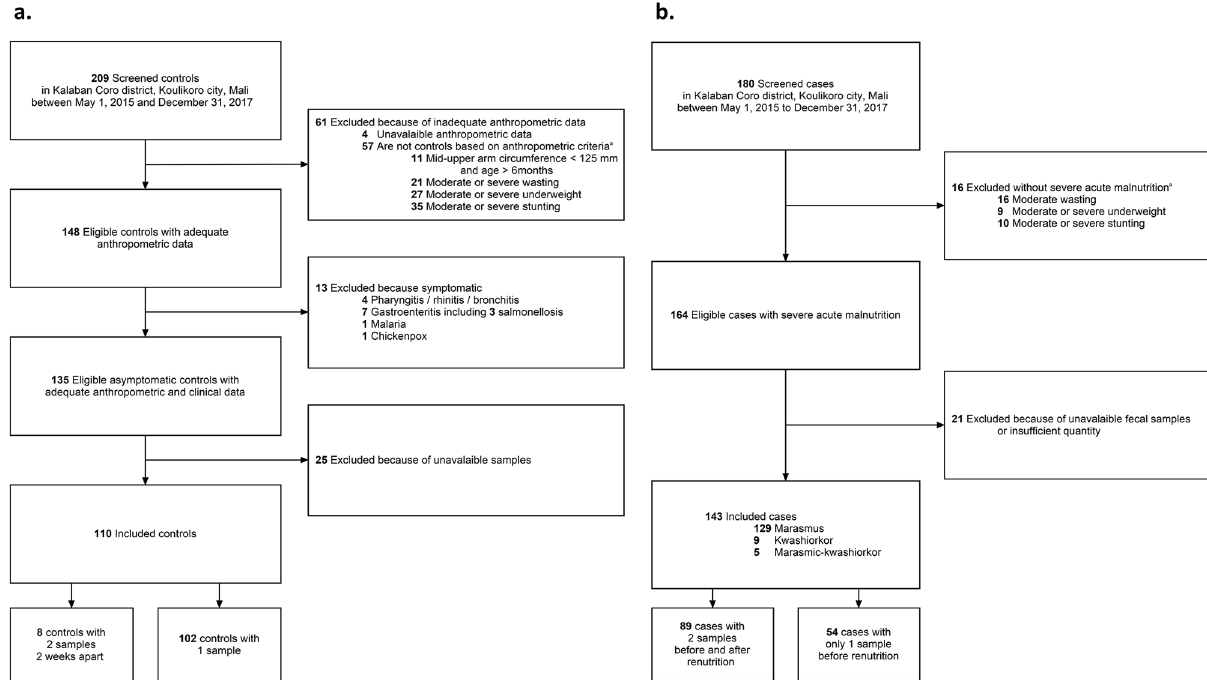
Figure 1. Study flow-chart. ( a ) Case selection, malnourished children are selected based on the WHO severity criterion and before any treatment; the presence of any symptoms or infection was not an exclusion criterion, ( b ) Control selection, healthy children are selected based on WHO standard without symptoms and antibiotics into the last 15